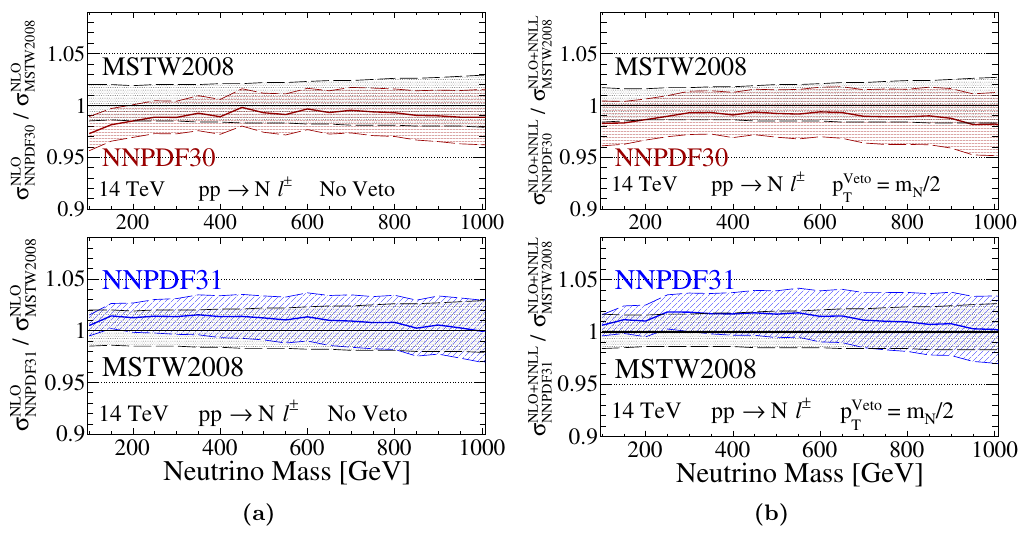
Figure 15. PDF uncertainty of the charged current Drell-Yan heavy neutrino production cross section at p s = 14 TeV (left) without a jet veto and (right) with a jet veto threshold p Veto